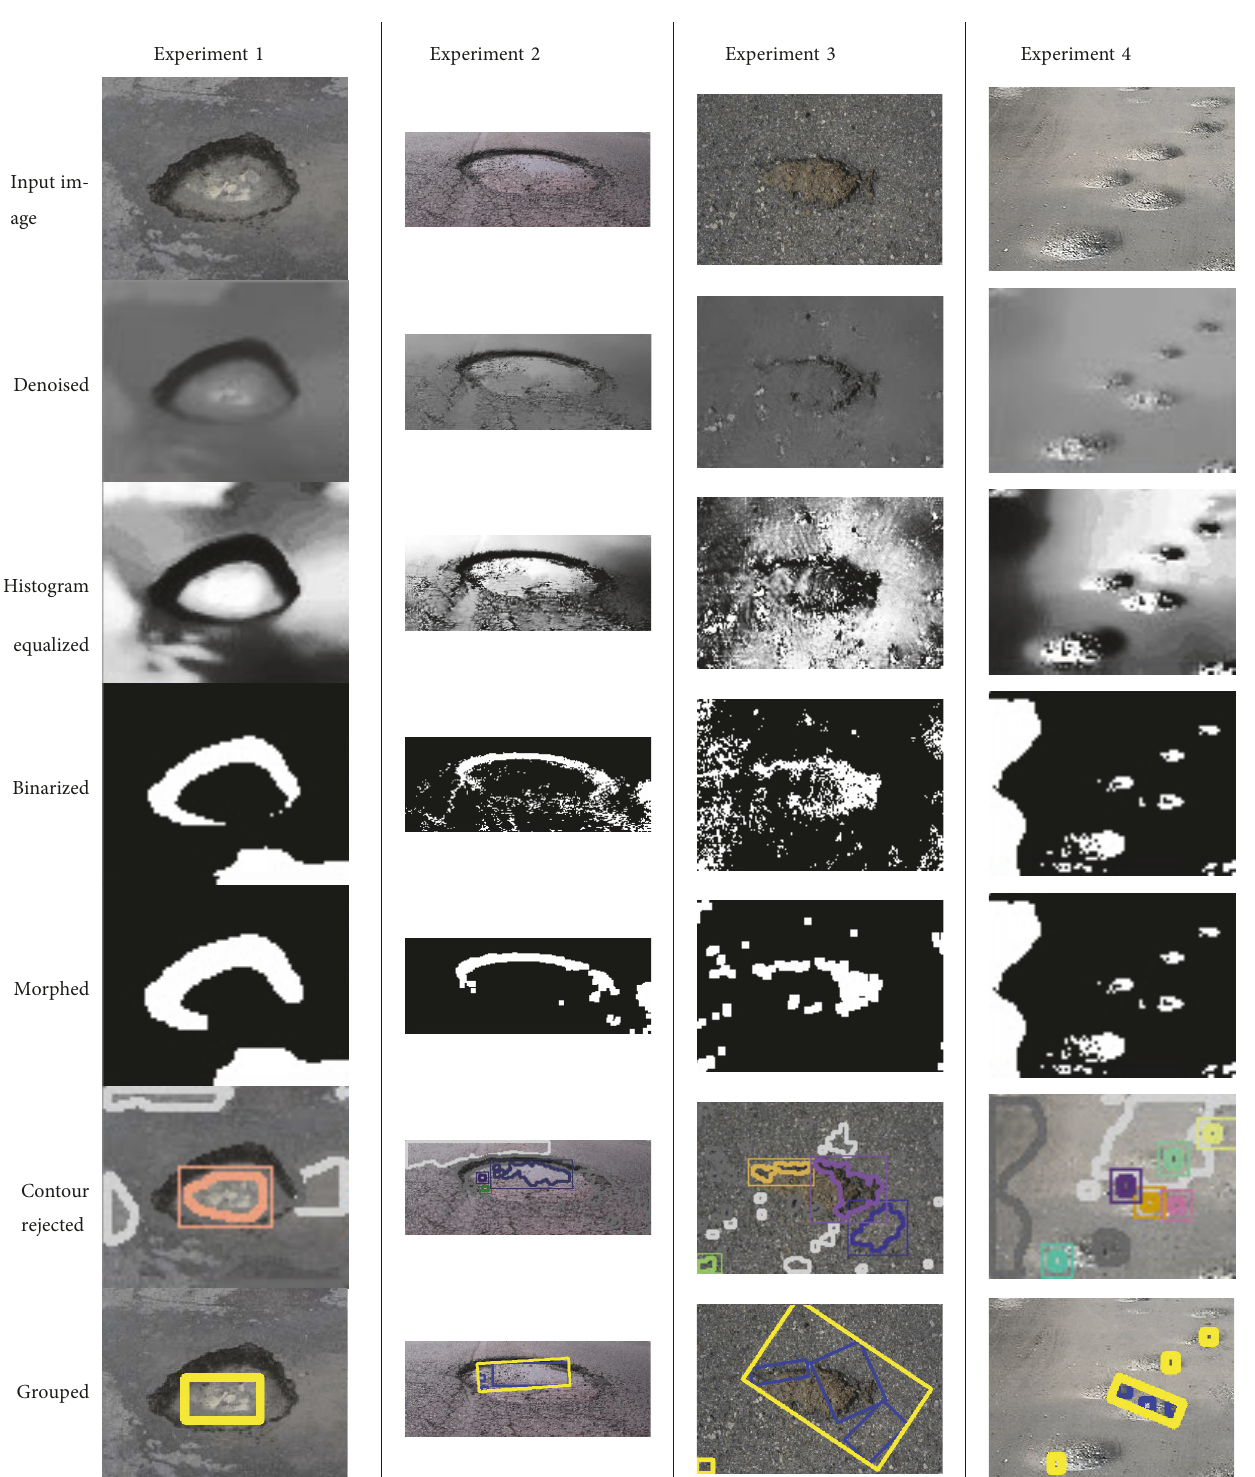
Figure 4: Results of the 1st–4th experiments . Pothole road distress detection and grouping based on 2D image analysis (sources of all input images are concluded in Table